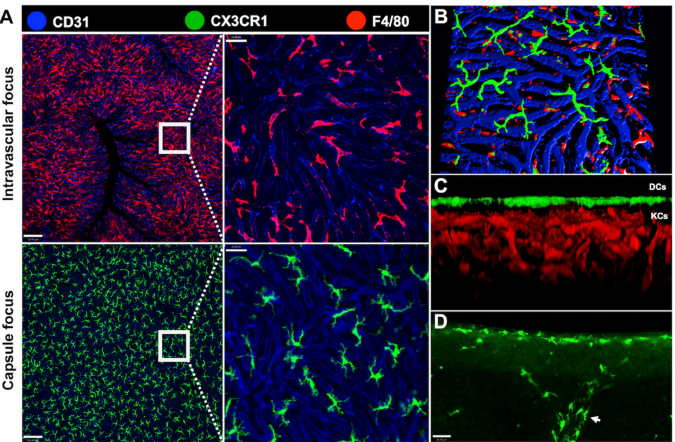
Figure 4. Distribution of hepatic phagocytes within liver intravascular and extravascular compartments. Intravital microscopy of CX3CR1 gfp/wt reporter mice enables the visualization of liver phagocytes in both intravascular and extravascular compartments. ( A ) Kupffer cells (in red) are observed in an intravascular focus. They are located inside the sinusoids, here stained with andi-CD31 PECAM-1 (in blue). Their location facilitates the capture of circulating bacterial products or intact bacteria by these cells. To image the extravascular cells only, the images were obtained in the capsule focus of the liver. There is an exclusively extravascular population of CX3CR1 + cells (in green) that inhabit the liver surface; ( B , C ) 3-dimensional reconstructions of liver compartments evidencing the intravascular population (KCs in red) and the extravascular population (DCs in green). The CX3CR1 + cells are found especially underneath the liver capsule and are rarely distributed in the parenchyma; ( D ) CX3CR1 + cells underneath the liver capsule and around a large vessel (arrow). Scale bars in ( A ), 120, 64, 36 µ m. Scale bars in ( D ), 26 µ m. All images were acquired using an inverted Nikon Eclipse Ti coupled to an A1 scanning head with no modifications. All animal studies were approved by the Animal Care and Use Committee at Universidade Federal de Minas Gerais, Brazil (CEUA